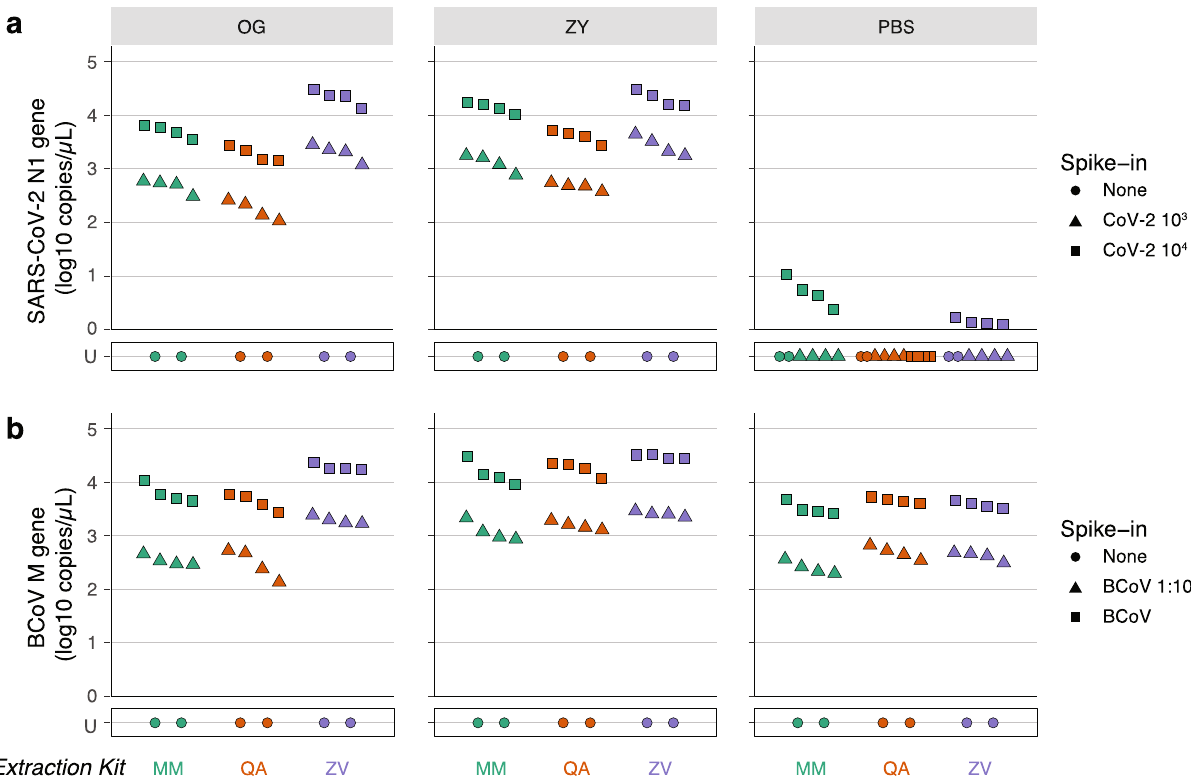
Fig. 2 Ef fi cacy of preservation and RNA extraction of SARS-CoV-2 and BCoV RNA from standardized NIST stool by ddPCR. Stool samples collected from omnivorous donors and processed into a single standardized matrix by NIST was spiked with ATCC CoV-2 RNA or BCoV vaccine. Spiked stool was preserved in the OMNIgene-GUT Kit (OG), Zymo DNA/RNA shield buffer (ZY), and PBS (as indicated in the tab on the top). RNA was extracted from these samples by two independent users, each in duplicate, using the MagMAX Viral/Pathogen Kit (MM; green), QIAamp Viral RNA Mini Kit (QA; orange), or Zymo Quick-RNA Viral Kit (ZY; purple) as indicated on the x -axis. RNA was assayed using ddPCR. a Absolute concentration of SARS-CoV-2 RNA assayed by ddPCR targeting the N1 gene is plotted on the y -axis. NIST stool matrix was spiked with 10 3 (triangle) or 10 4 (square) copies of ATCC synthetic SARS-CoV-2 RNA. b Absolute concentration of BCoV RNA assayed by ddPCR targeting the M gene is plotted on the y -axis. NIST stool matrix was spiked with 1:10 diluted (triangle) or undiluted (square) BCoV vaccine. Control samples with no spiked in RNA (none; circle) were included in duplicate to estimate LoB. U stands for undetermined and marks samples with no detectable RNA above LoB. Two-sided paired T tests were performed on n = 4 independent extractions for each spike-in condition. Associated statistics are summarized in Supplementary Data 2. Source data are provided as a Source data fi